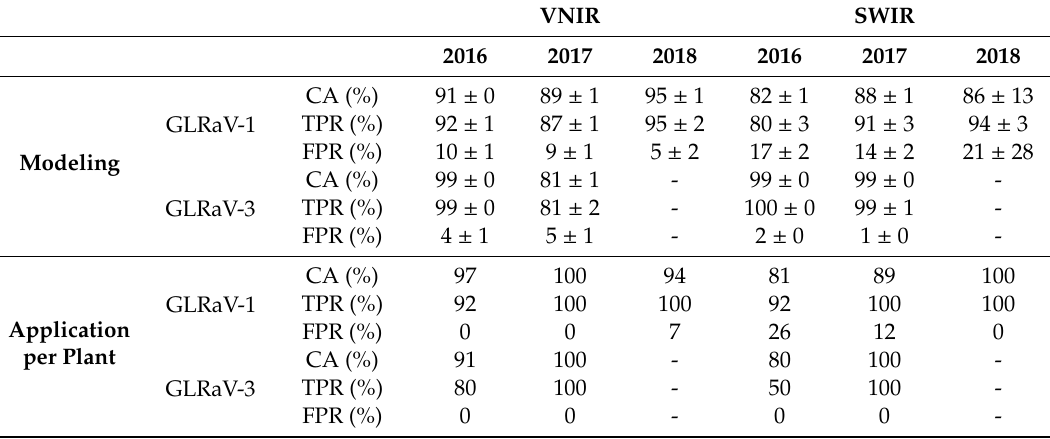
Table 11. Results for virus-wise (GLRaV-1, -3) di ff erentiation of white and red symptoms of field-grown grapevines. For modeling, all pixels were evaluated not considering spatial scales. Developed models were then applied per plant using all leaves for majority